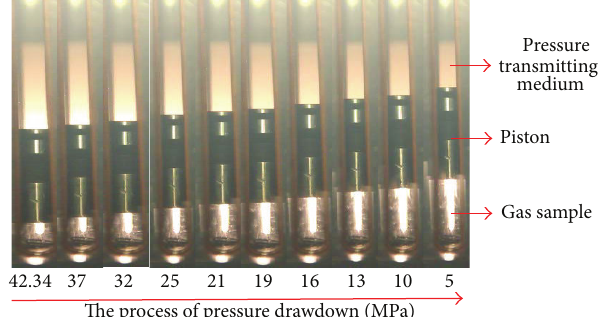
Figure 15: Phase transition of high CO 2 content natural gas samples (75.323 mol%) in the process of pressure drawdown at 35 ∘ C.